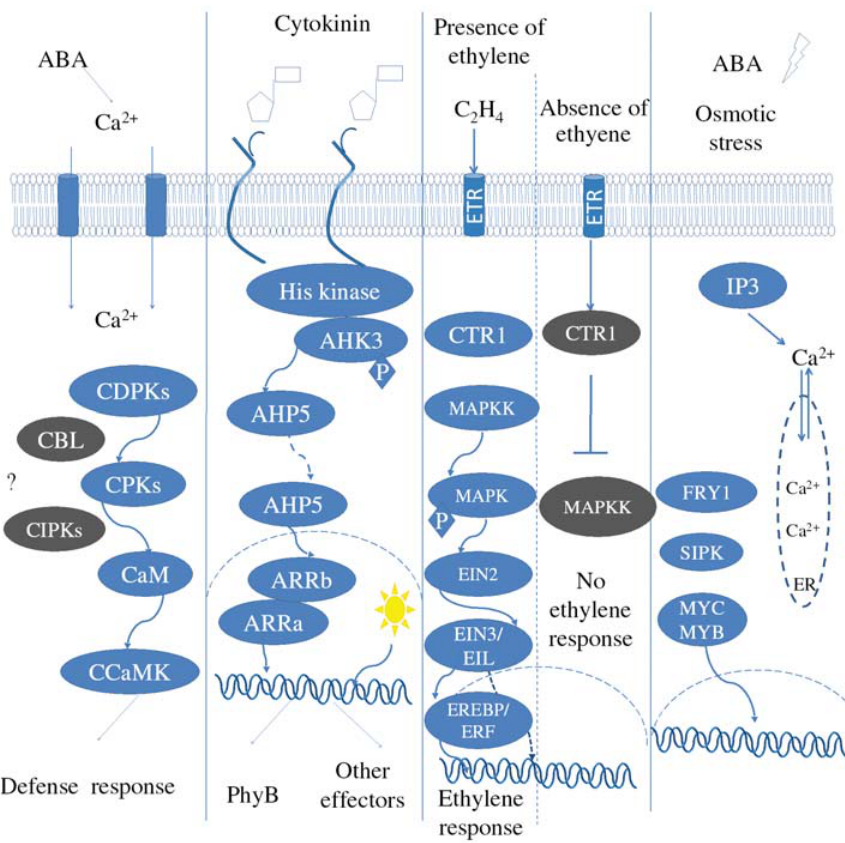
Figure 1 - Schematic representation of signaling cascades in Citrus. A. Calcium signaling components: CDPK (calcium-dependent protein kinase), CPK (calcium protein kinase), CaM (calmodulin), CCaMK (calcium- and calmodulin-dependent protein kinase), CBL (calcium sensor calcineurin B-like pro- tein), CIPKs (CBL interacting protein kinases); B. cytokinin components: AHK3 (histidine kinase), AHP5 ( Arabidopsis histidine phosphotransfer), ARRa and ARRb ( Arabidopsis response regulator); C. Ethylene components: ETR (Ethylene receptor), CTR (Constitutive triple response), MAPKK